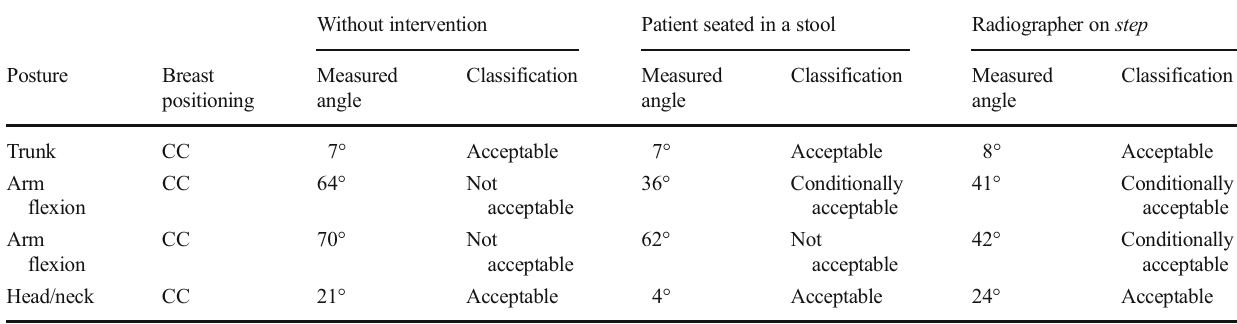
Angles measured on the radiographer during CC breast positioning (radiographer smaller than the patient) Without intervention